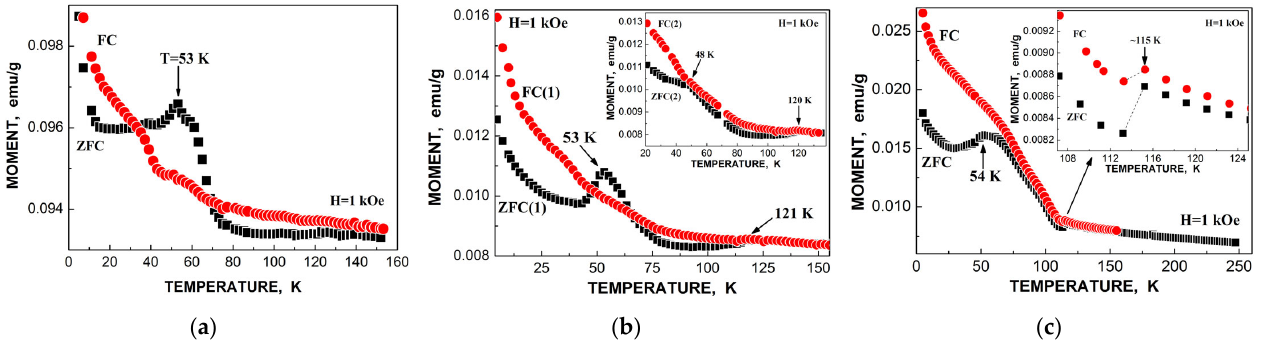
Figure 17. Selected zero ‐ field ‐ cooled (ZFC) and field ‐ cooled (FC) curves of liver tissues from nor ‐ mal human “2” measured 7 months after the first run ( a ) and patients with mantle cell lymphoma “N” with the first run marked (1) and inset with the second run marked (2) ( b ) and acute myeloid leukemia “Ch” ( c ). Adapted from Ref. [59] with permission from Springer Nature: Cell Biochemis ‐ try and Biophysics, “The iron state in spleen and liver tissues from patients with hematological malignancies studied using magnetization measurements and Mössbauer spectroscopy”, Alenkina I.V., Vinogradov A.V., Felner I., Konstantinova T.S., Kuzmann E., Semionkin V.A., Oshtrakh M.I., ©2019; and from Ref. [60] with permission from Elsevier: Journal of Magnetism and Magnetic Ma ‐ terials, Vol. 399, Felner I., Alenkina I.V., Vinogradov A.V., Oshtrakh M.I., “Peculiar magnetic ob ‐ servations in pathological human liver”, 118–122, ©2016.